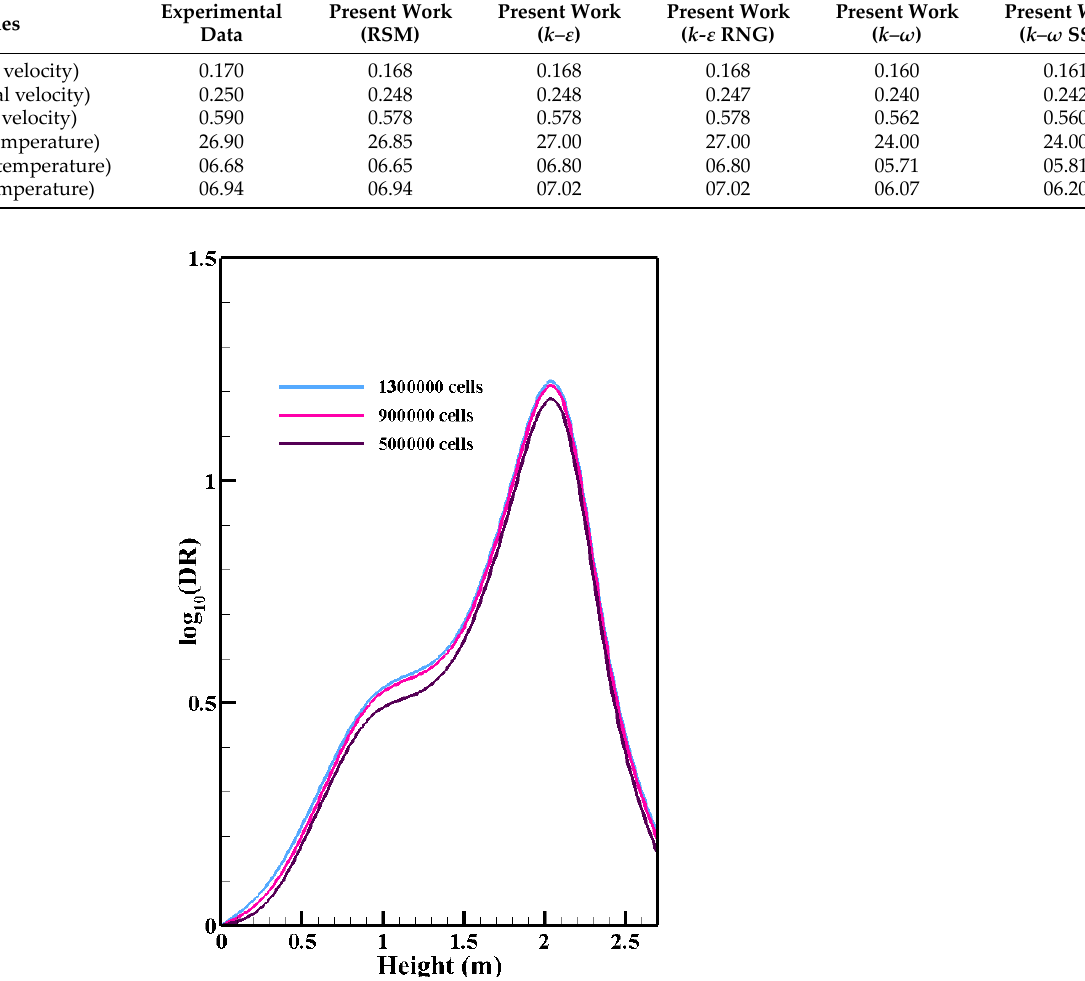
Figure 6. Log 10 (DR) at 20 cm in front of mouth vs position along the height of urban subway ob- tained using coarse mesh 500,000, fine mesh 900,000, and finest mesh 1,300,000 (the structures of these meshes are shown in Figure 3). DR is the ratio of the continuous breathing source concentra- tion to the initial concentration in the subway cabin.